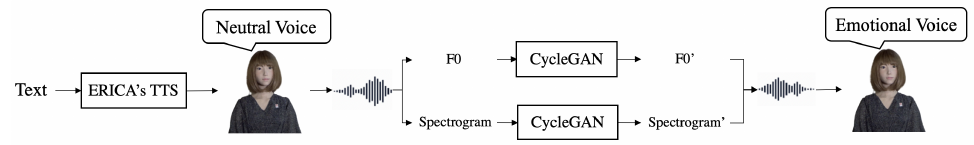
Figure 2. Flow of obtaining emotional voice.